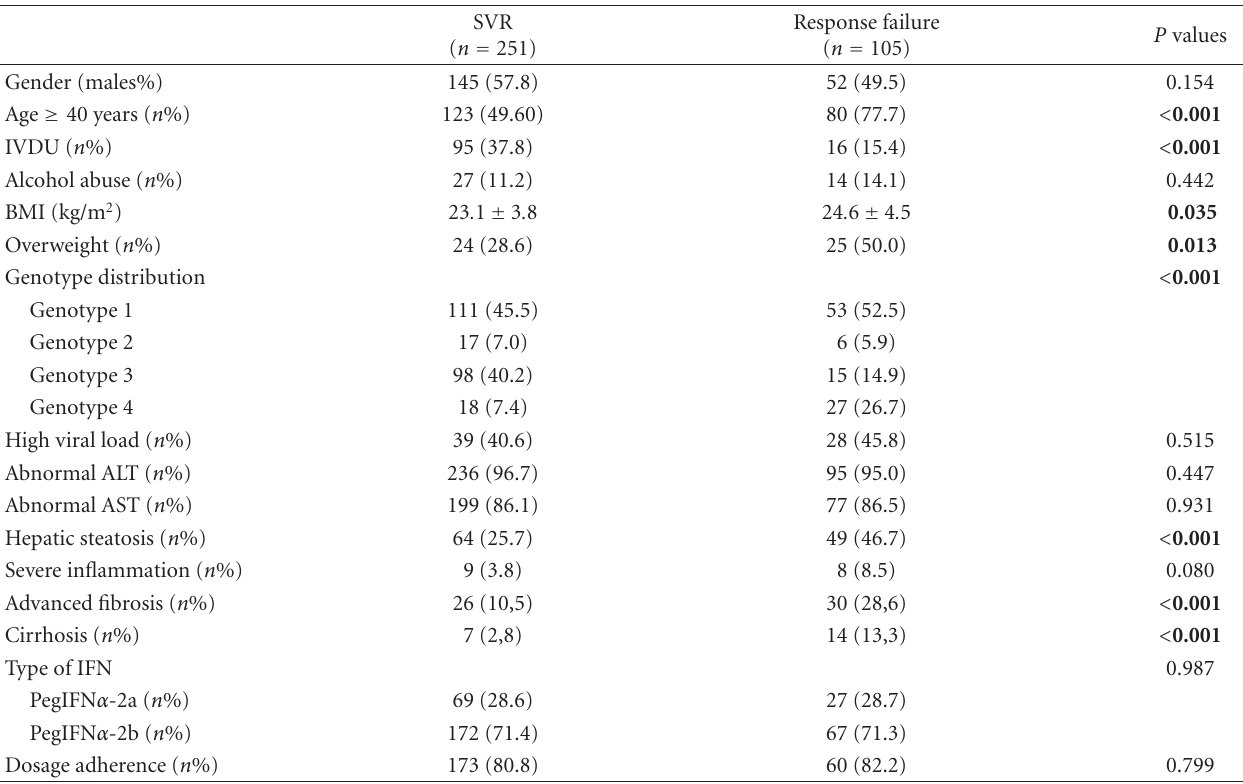
Table 2: Variable associations with SVR.